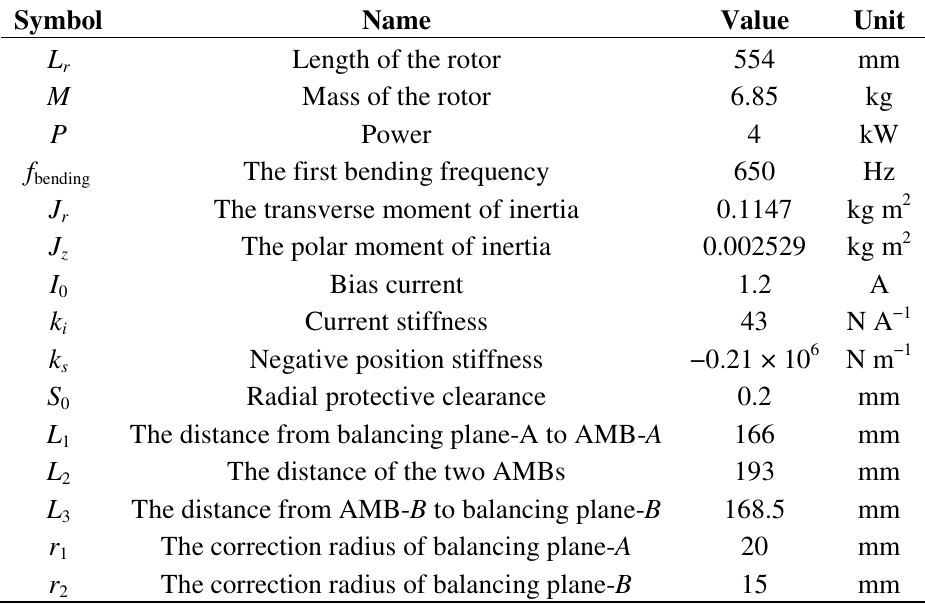
Table 1. Design parameters of the 4 kW MLM.